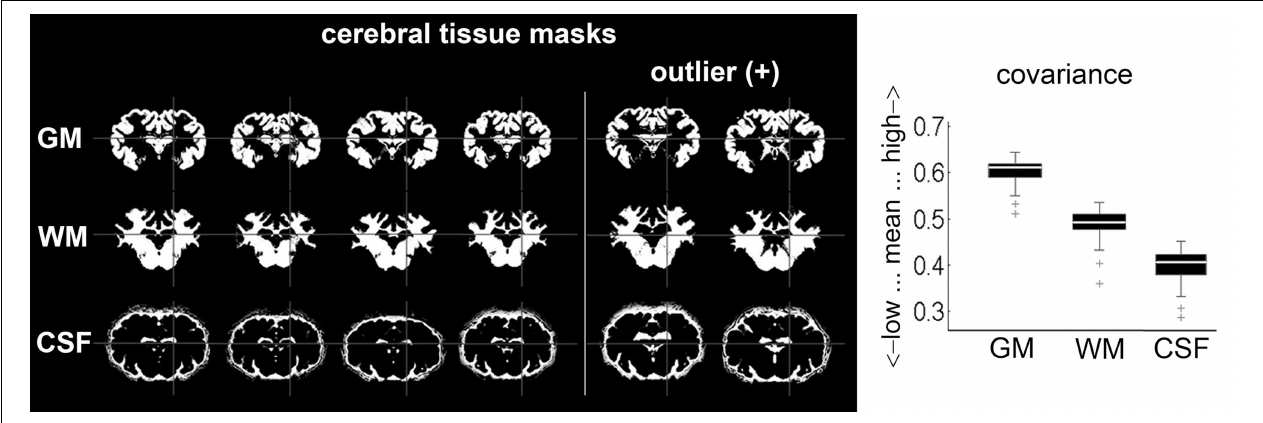
FIGURE 6 | Mean covariance from automatically segmented tissue masks ( n = 38 ): six exemplary results (including the two only detected GM; WM and CSF outliers) after segmentation procedure with SPM. Outliers were subjected to careful visual